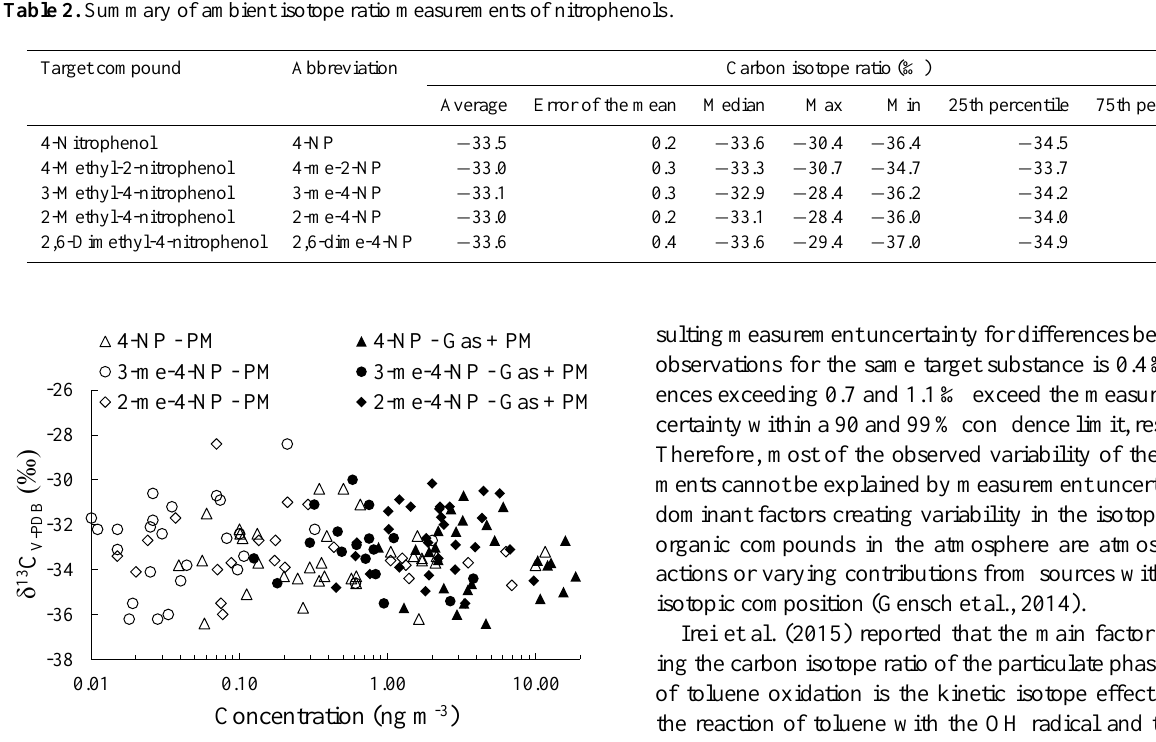
Figure 3. Plot of isotope ratio values as a function of concen- tration for 4-nitrophenol, 3-methyl-4-nitrophenol and 2-methyl-4-